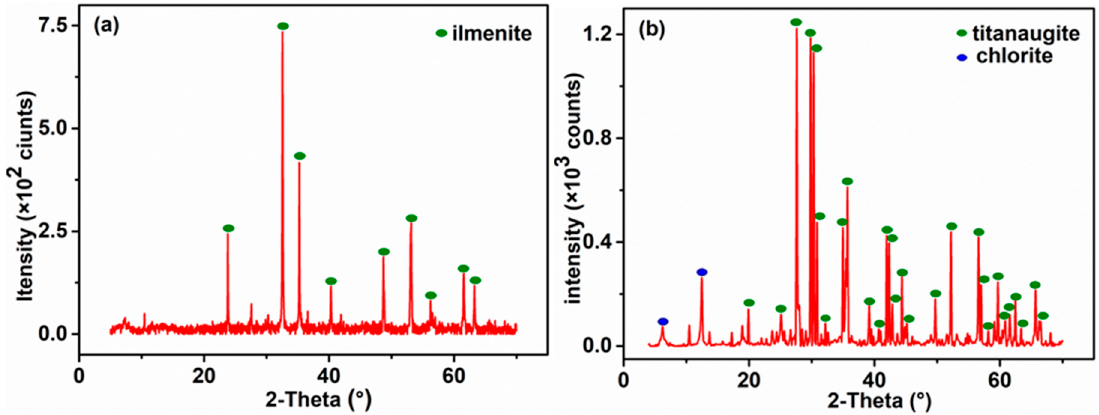
Figure 1. XRD spectra of ilmenite ( a ) and titanaugite ( b ).